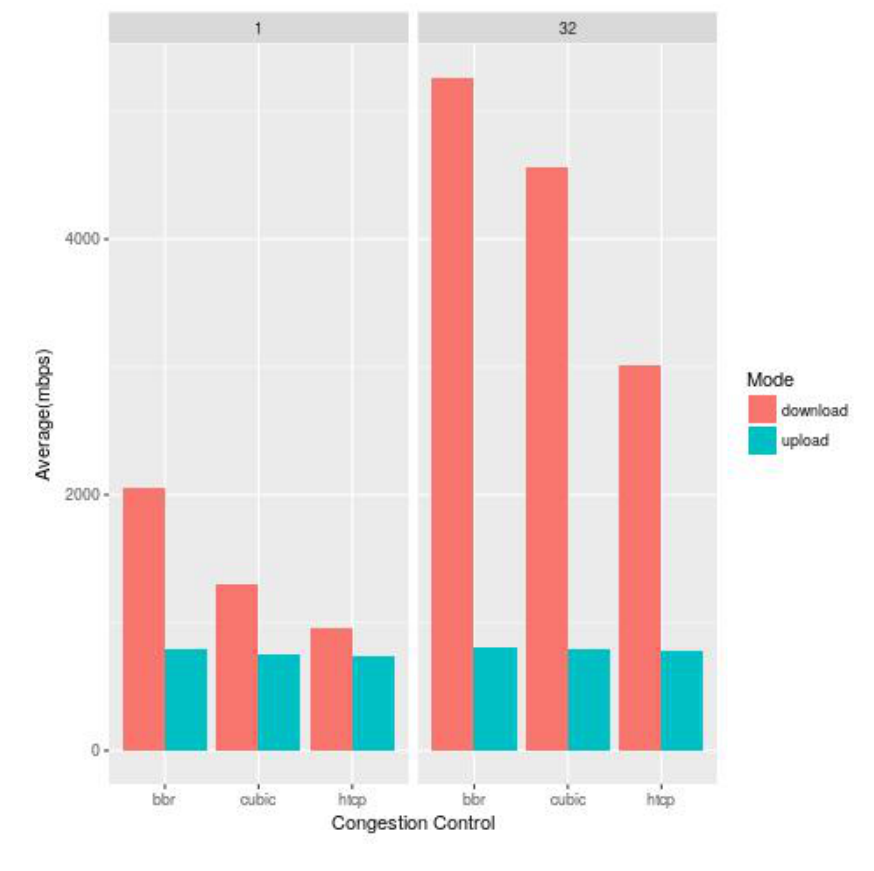
Figure 1. Brunel-Singaren upload and download iperf3 tests